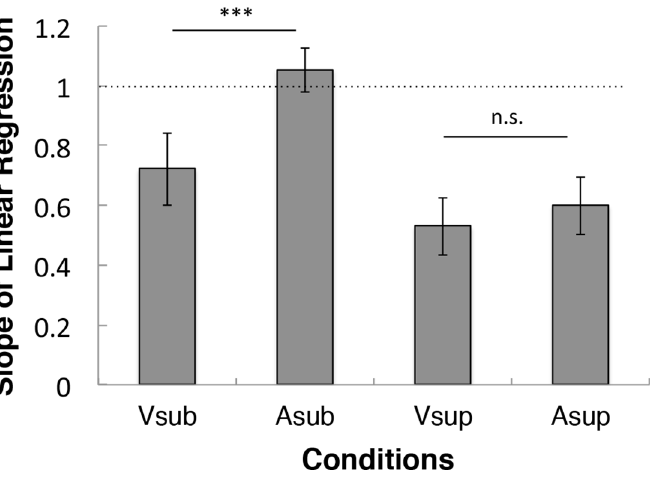
Fig 3. Quantification of the central tendency. The slopes of the linear regressions are presented for all four conditions. A and V represent auditory and visual stimuli, respectively. Sub and sup represent sub-second and supra-second intervals, respectively. Error bars represent the standard error of the mean. *** p < .001, n.s. = not significant.